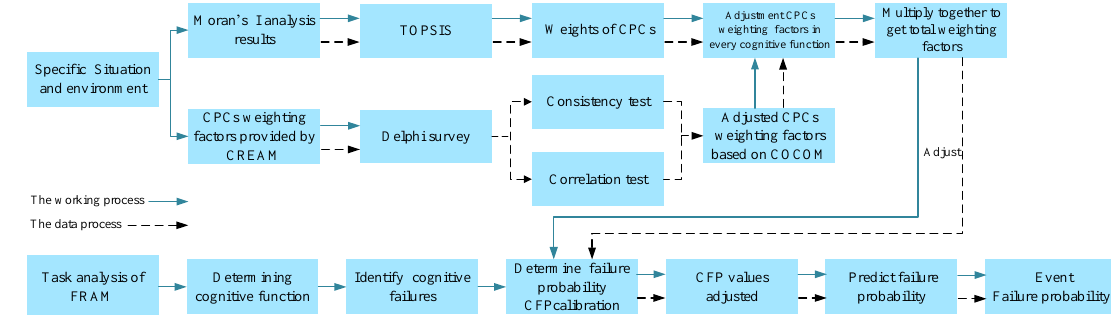
Figure 3. The flow chart of improved CREAM.